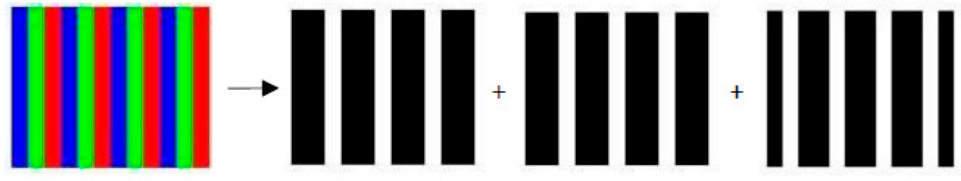
Figure 2. The features of the composite CBF and the segmentation.